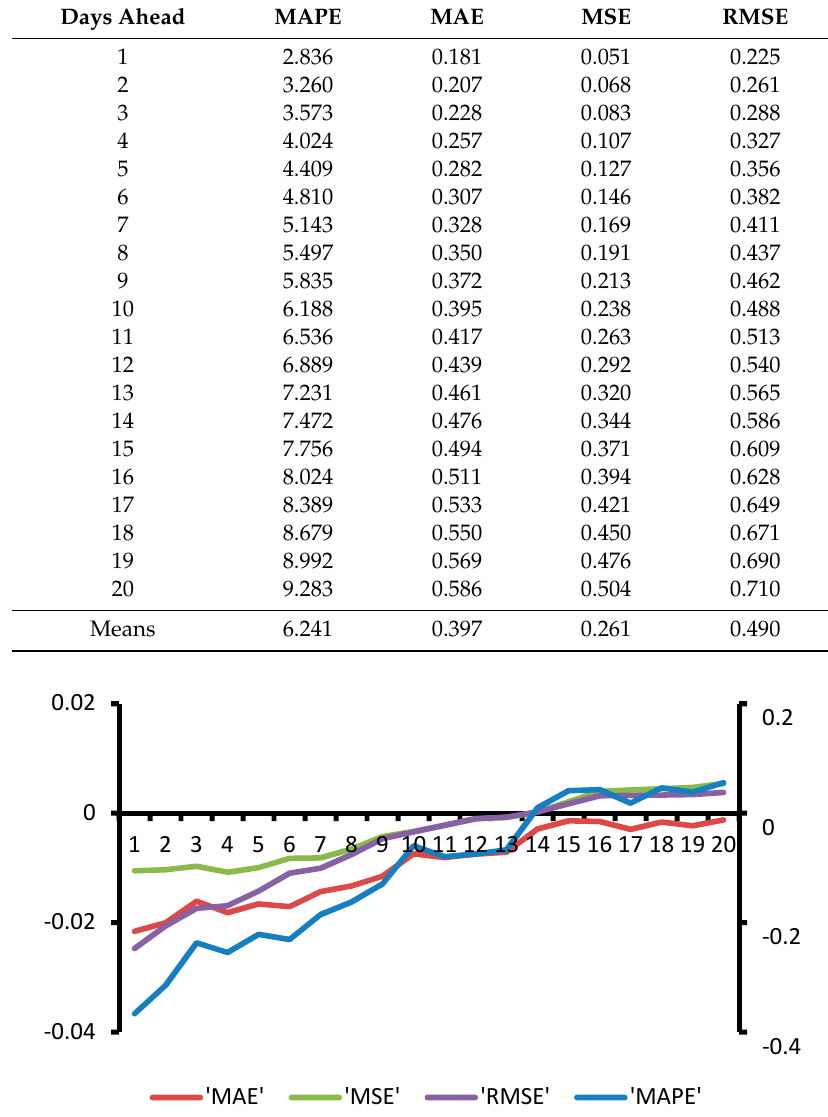
Figure 2. Differential errors between predictions when using prices of CO 2 emission allowances only and when exogenous variables (power and iron and steel sector prices) were added.